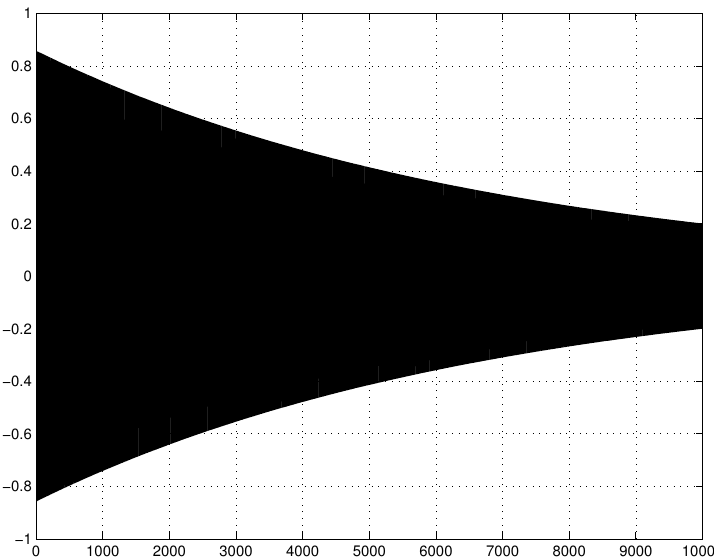
Figure 2. The trajectories of states x 1 and x 2 of (19) with constant delay h =